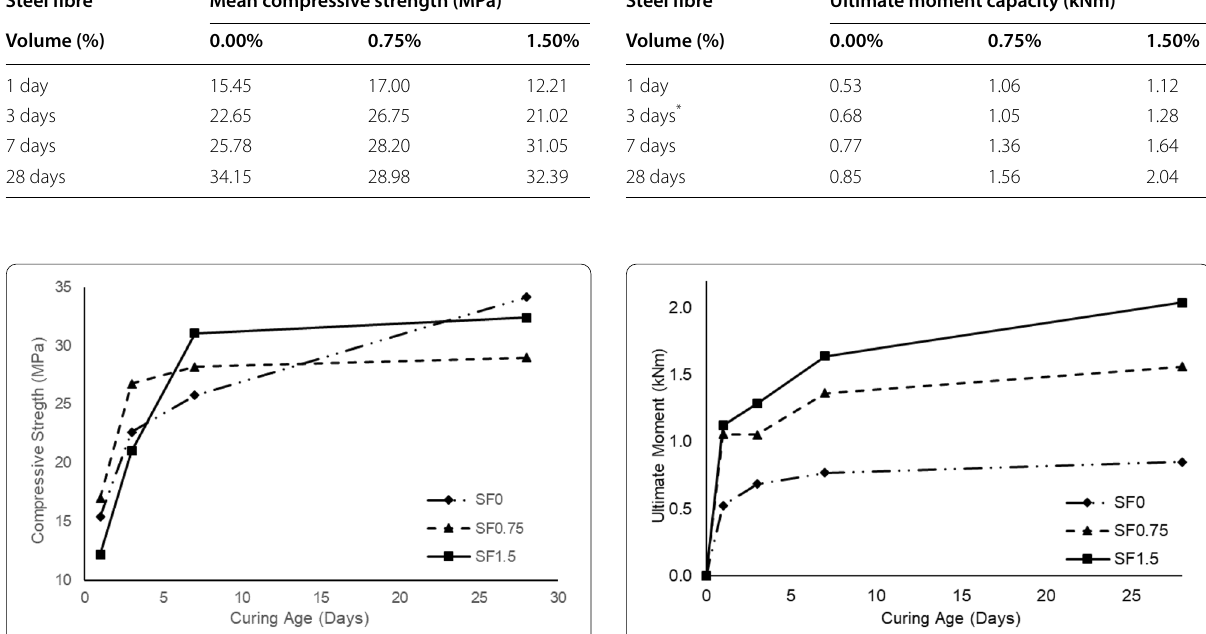
Fig. 5 Maximum moment vs. curing